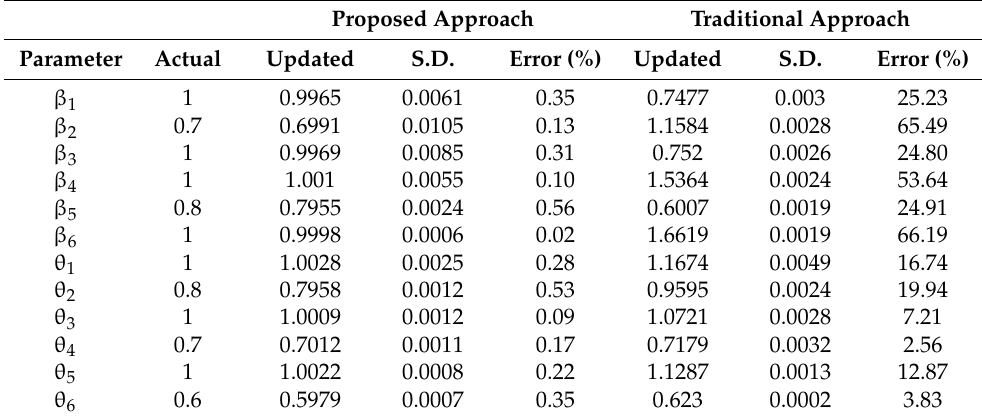
Table 6. Results of updated structural parameters for damage case No.2.